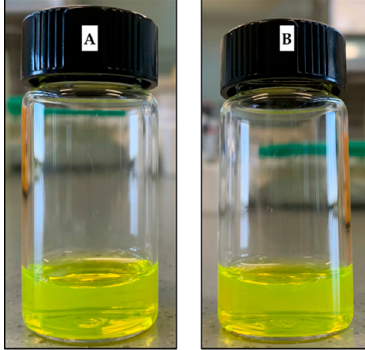
Figure 2. Visual appearance of the fluorescent nanomicelles. ( A ) FITC-loaded PNM; ( B ) FITC-loaded MNM.